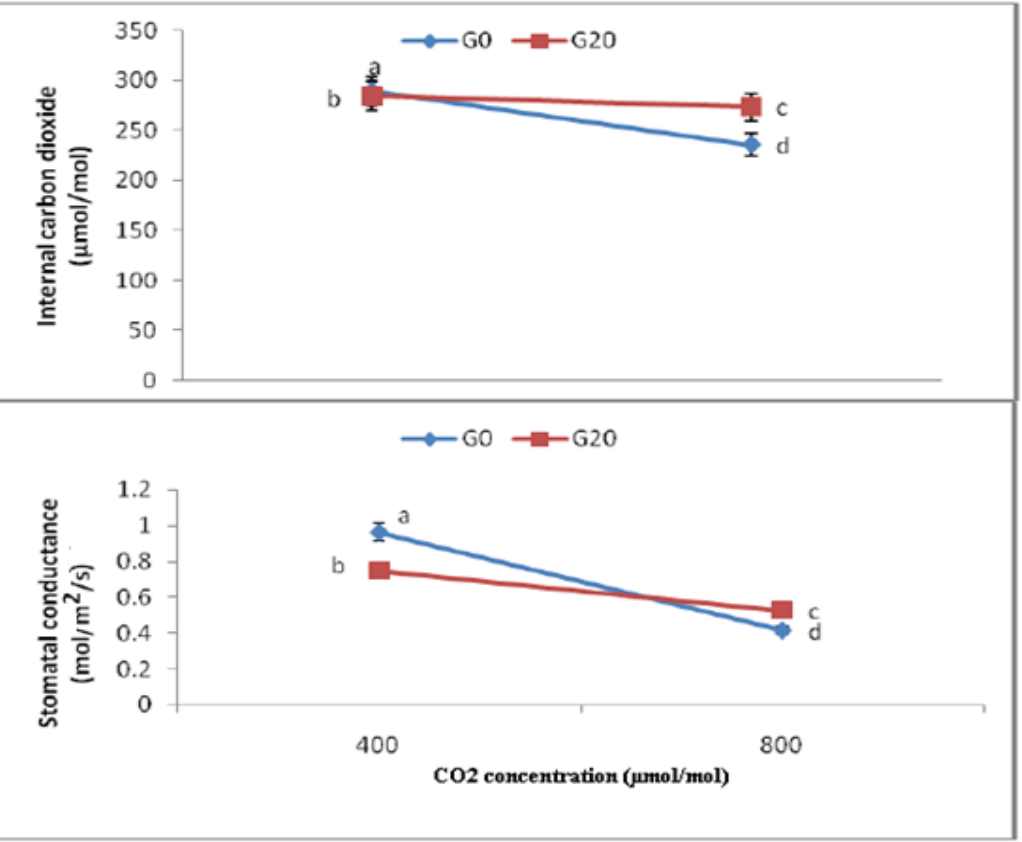
Figure 4. Effects of different CO carbon dioxide of plants of C.asiatica ; n = 2 (400 = Ambient CO CO 2